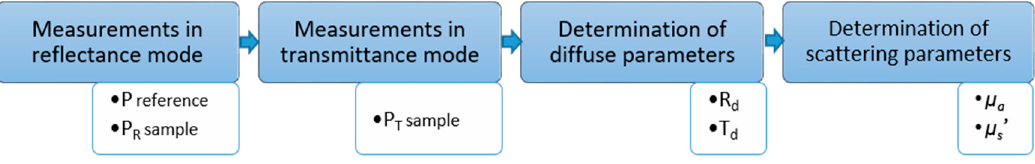
Figure 4. Block diagram of the data analysis algorithm, where P R —reference measurement using the CS-A21 white calibration plate in reflectance mode. P R sample , P T sample —measurements of the investigated phantom in reflectance and transmittance modes, respectively. T d —diffuse transmittance. R d —diffuse reflectance. µ a —absorption coefficient. µ s ’—reduced scattering coefficient.